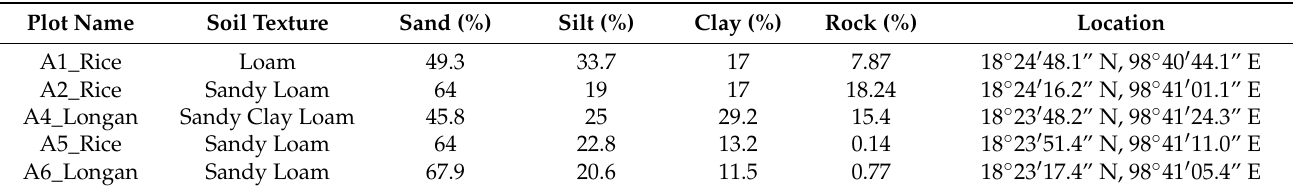
Table 2. Summary of soil properties for each plot in testing area.